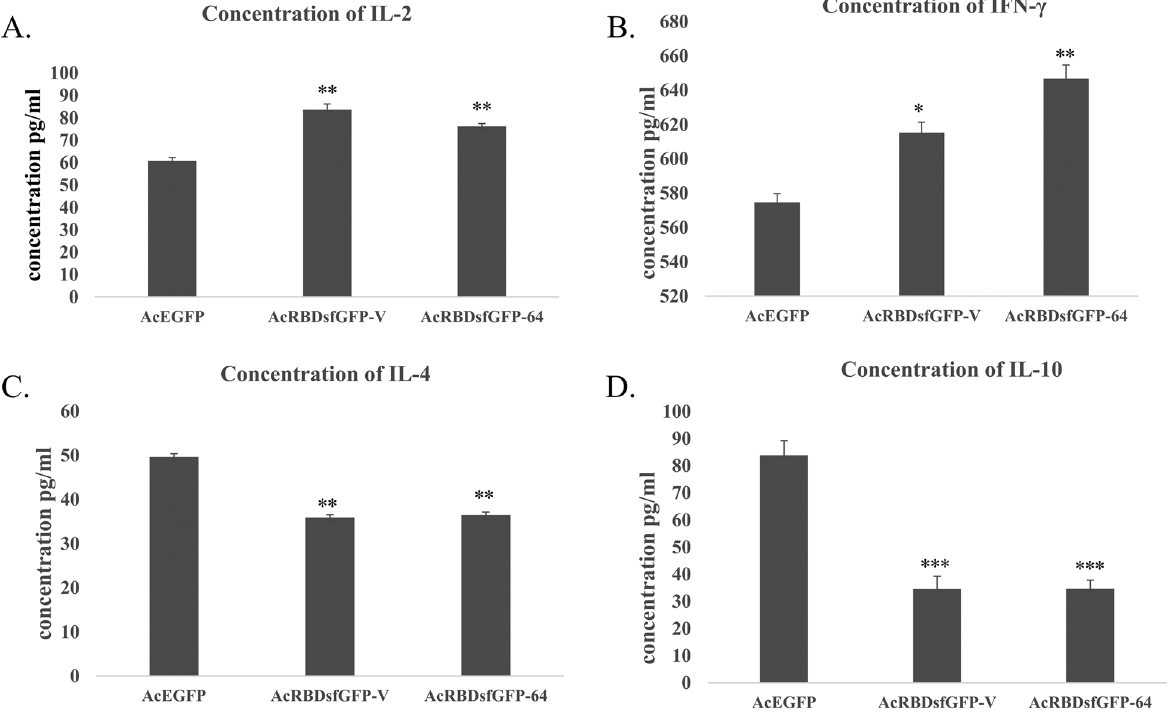
Fig. 4 ELISA readings for splenic extracted cytokines show Th1 response in baculovirus displaying RBDsfGFP. A IL-2, B IFN-γ, C IL-4, and D IL-10 in splenocytes of mice after injection with AcEGFP, AcRBDsfGFP-V, and AcRBDsfGFP-64. Data presented as